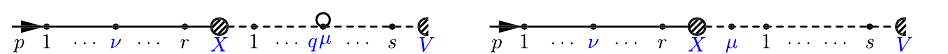
Fig. 14 Typical diagrams contributing to insertions of vertices μ on the intermediate scalar (dashed) line and ν on the initial fermion (solid) line. The p (cid:6) leg remains unaffected by the insertions and hence is not shown